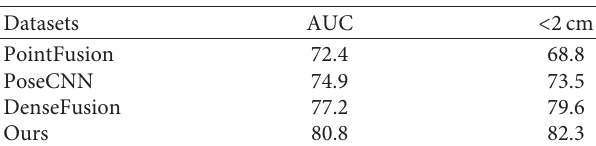
Table 2: Quantitative comparison of 6D object pose estimation on the ShapeNet